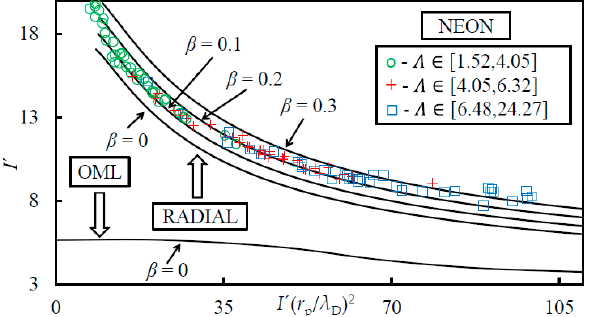
Figure 2. Neon plasma Sonin plot for the normalized probe potential y SP = 25. Experimental data for the neon plasma: green circles for 1.52 ≤ Λ ≤ 4.05, red crosses for 4.05 ≤ Λ ≤ 6.32 and blue squares for 6.48 ≤ Λ ≤ 24.27. In solid lines, the orbital and radial theoretical curves are shown. Appl. Sci. 2020 , 10 , x FOR PEER REVIEW